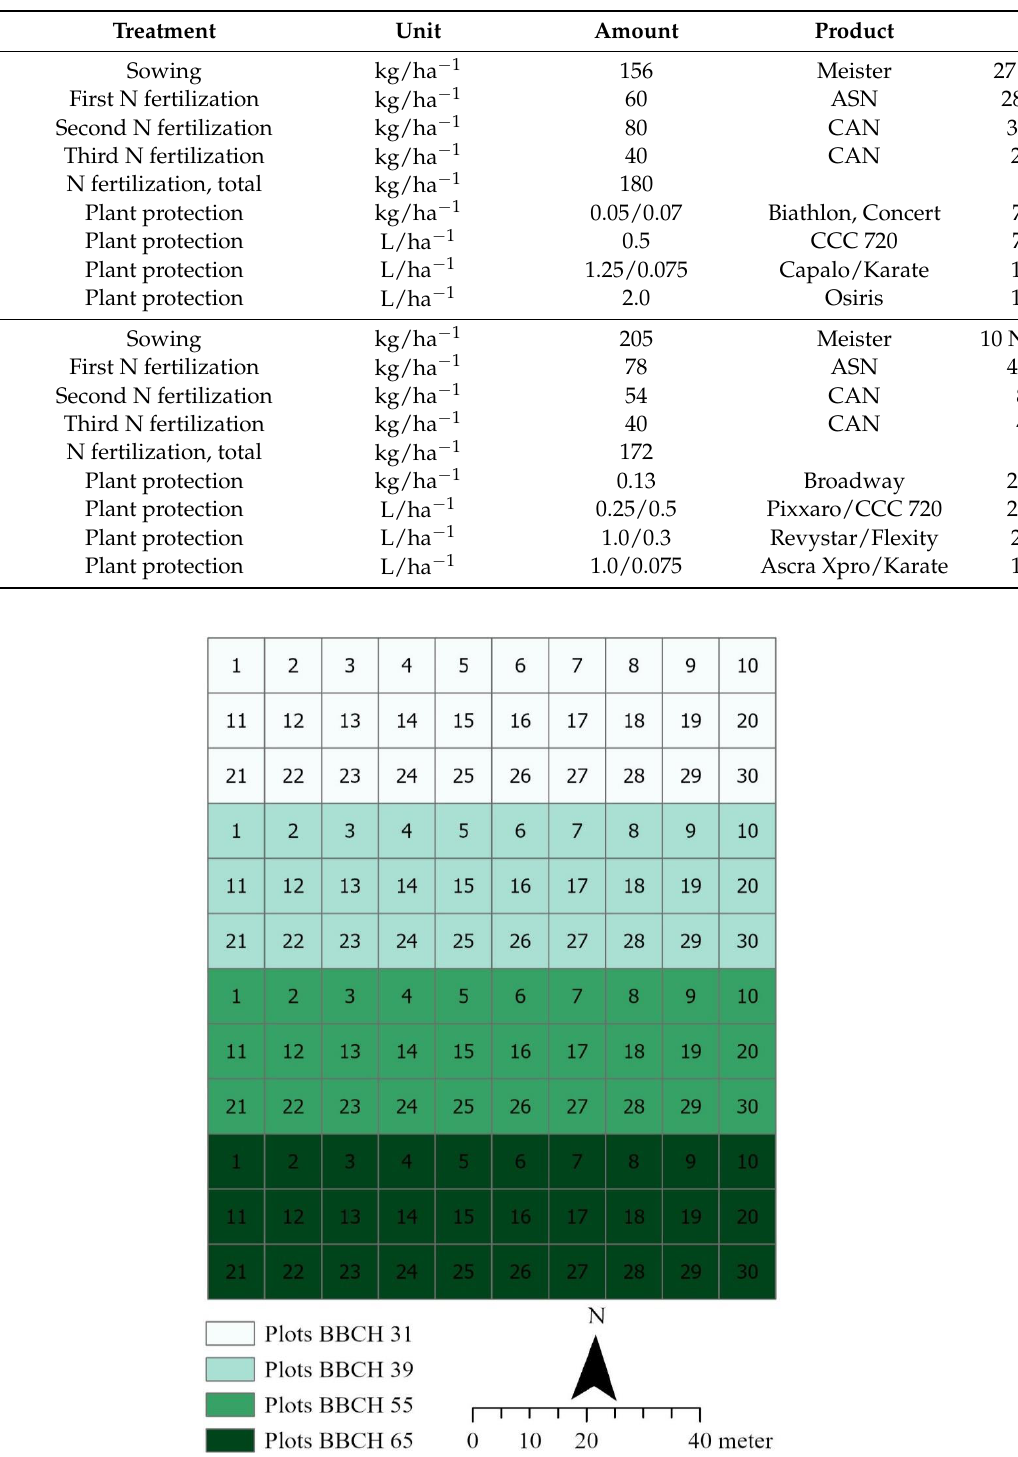
Figure 1. Experimental setup (Field A, 2020). Nitrogen uptake was determined using the respective methods in the growth stages, BBCH 31, BBCH 39, BBCH 55, and BBCH 65. Thus, an area of 2.5 m 2 of plants was manually cut off in each plot for the ground truth data. These samples were weighed, chopped, and dried at 105 ◦ C. This resulted in the above-ground biomass yield. The Dumas method was used to analyze the nitrogen content of the samples, and the nitrogen uptake of the